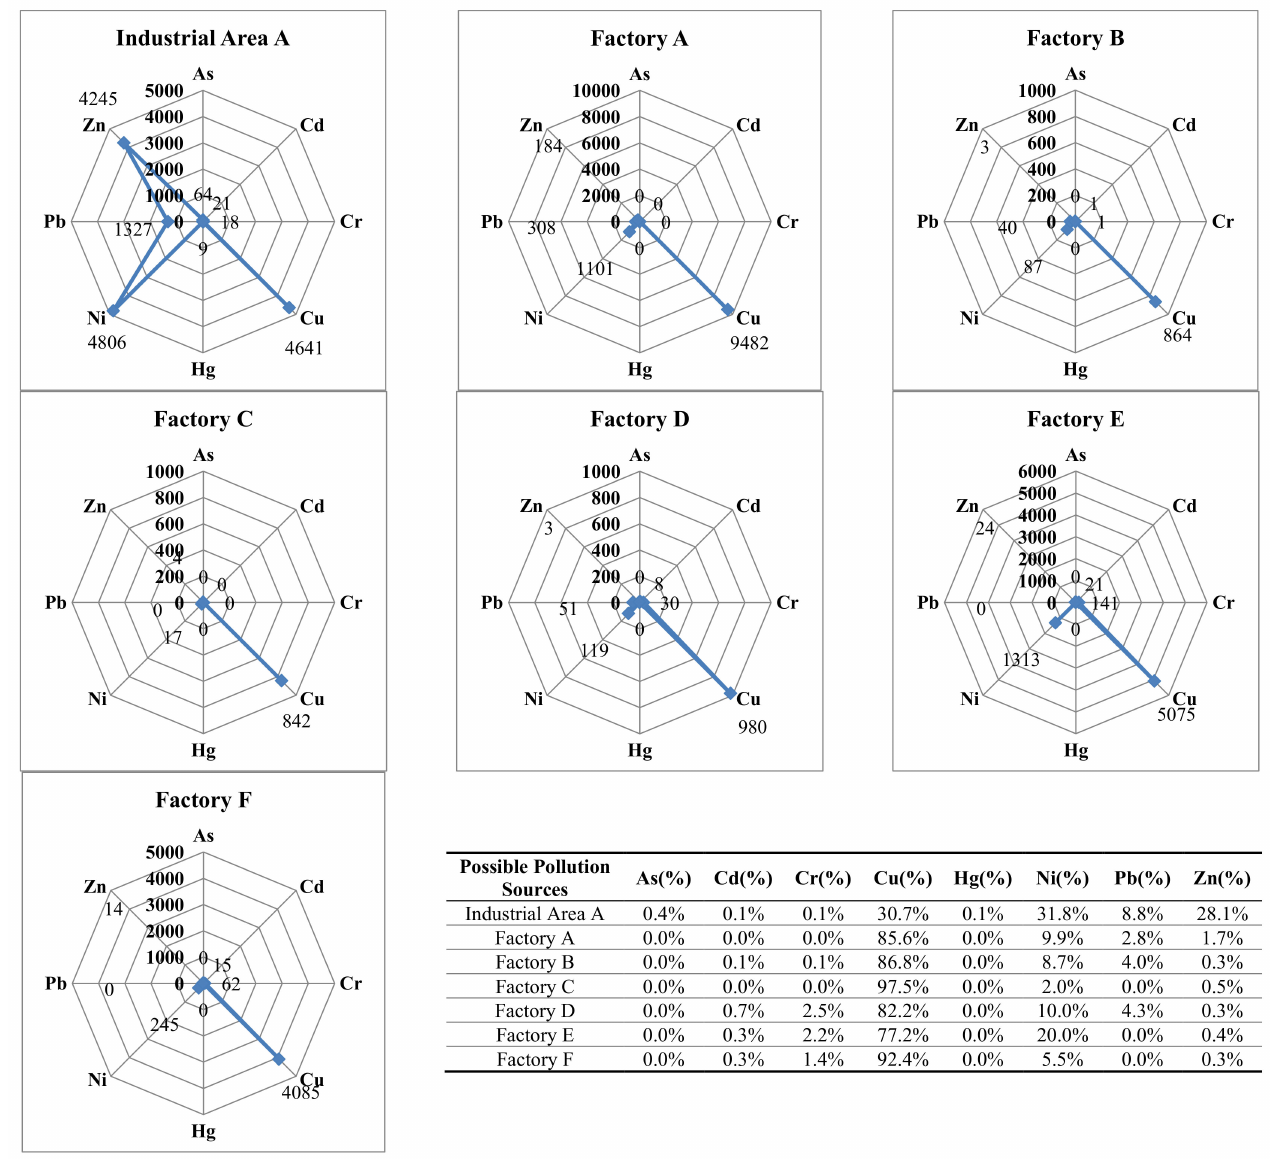
Figure 8. Radar charts of heavy metal mass of release at pollution sources near sediment pollution sites in TY4 (Note: Total mass of release of heavy metals during the period 2014–2019, unit: